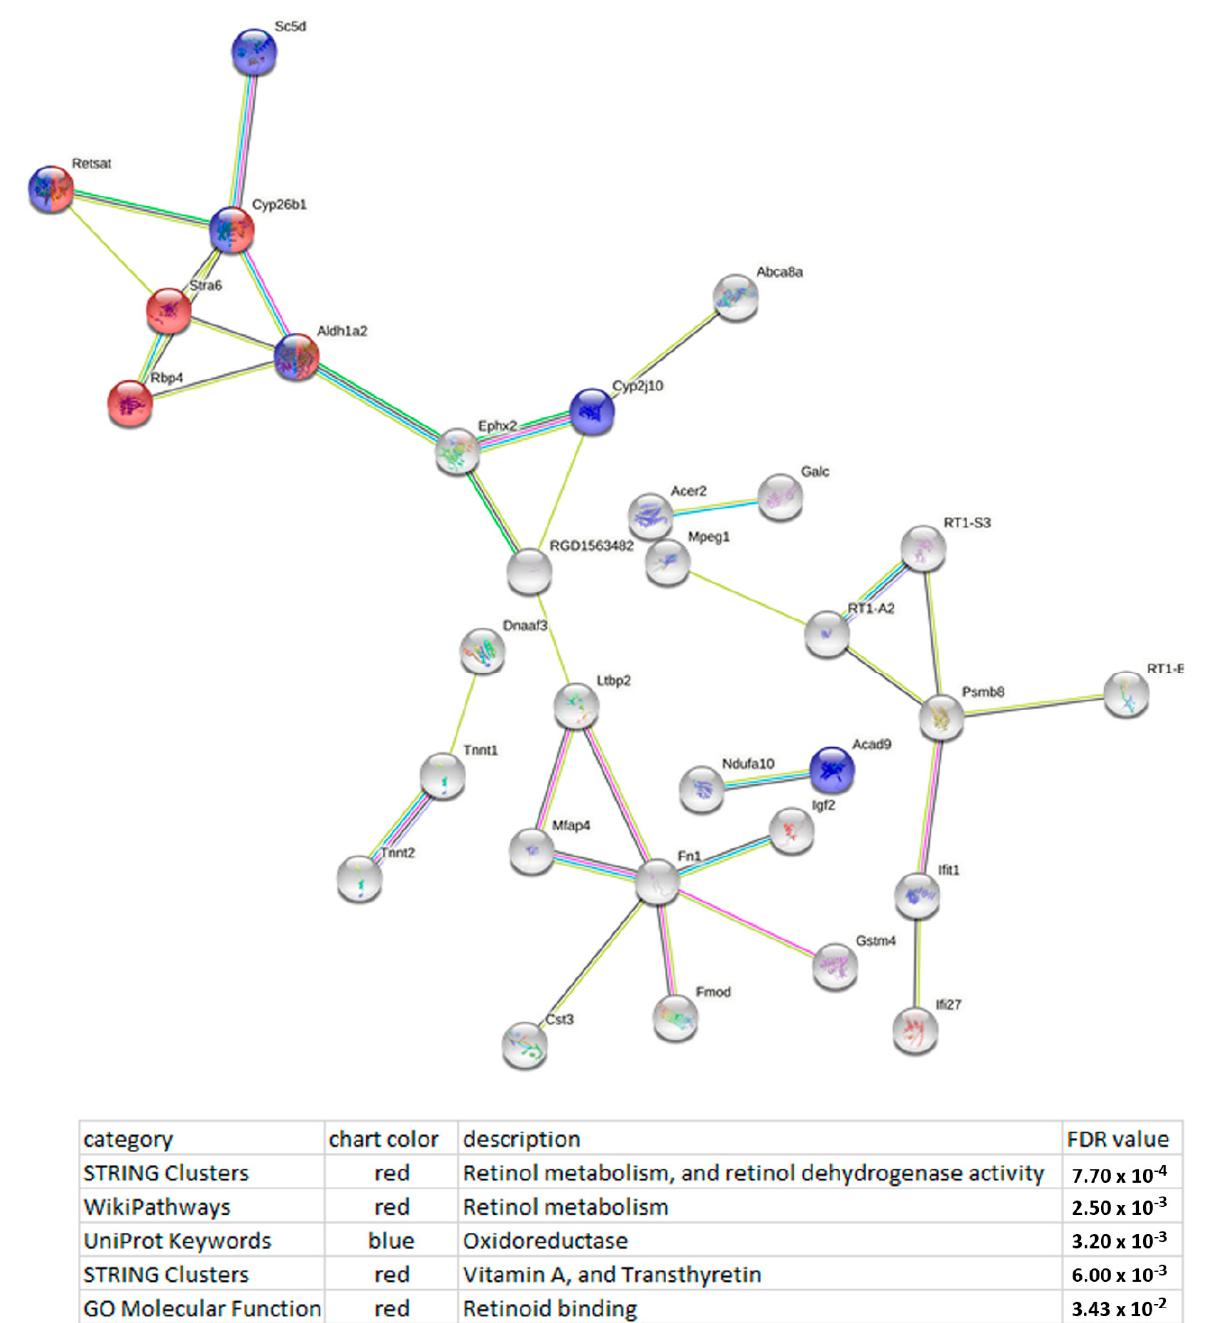
Figure 5. Functional enrichment analysis of the lncRNA LOC100910237 network points to possible association of this lncRNA with retinol metabolism and oxidation–reduction (redox) processes. The functional enrichment network was constructed with the help of the STRING database [22] using the DEGs whose expression correlated with the expression of lncRNA LOC100910237. Each node represents all the proteins produced by a single protein-coding gene. The key nodes are retinol binding protein 4 (Rbp4); cytochrome P450, family 26, subfamily b, polypeptide 1 (Cyp26b1); retinol saturase (Retsat); signaling receptor and transporter of retinol STRA6 (Stra6); and aldehyde dehydrogenase 1 family, member A2 (Aldh1a2). Purple lines indicate experimentally determined interactions; blue lines represent known interactions from curated databases; dark blue lines denote gene co-occurrence; black lines indicate coexpression; green lines mean results of text mining; and grey lines indicate protein homology. Protein–protein interaction (PPI) enrichment p -value: 3.02 × 10 − 5 .